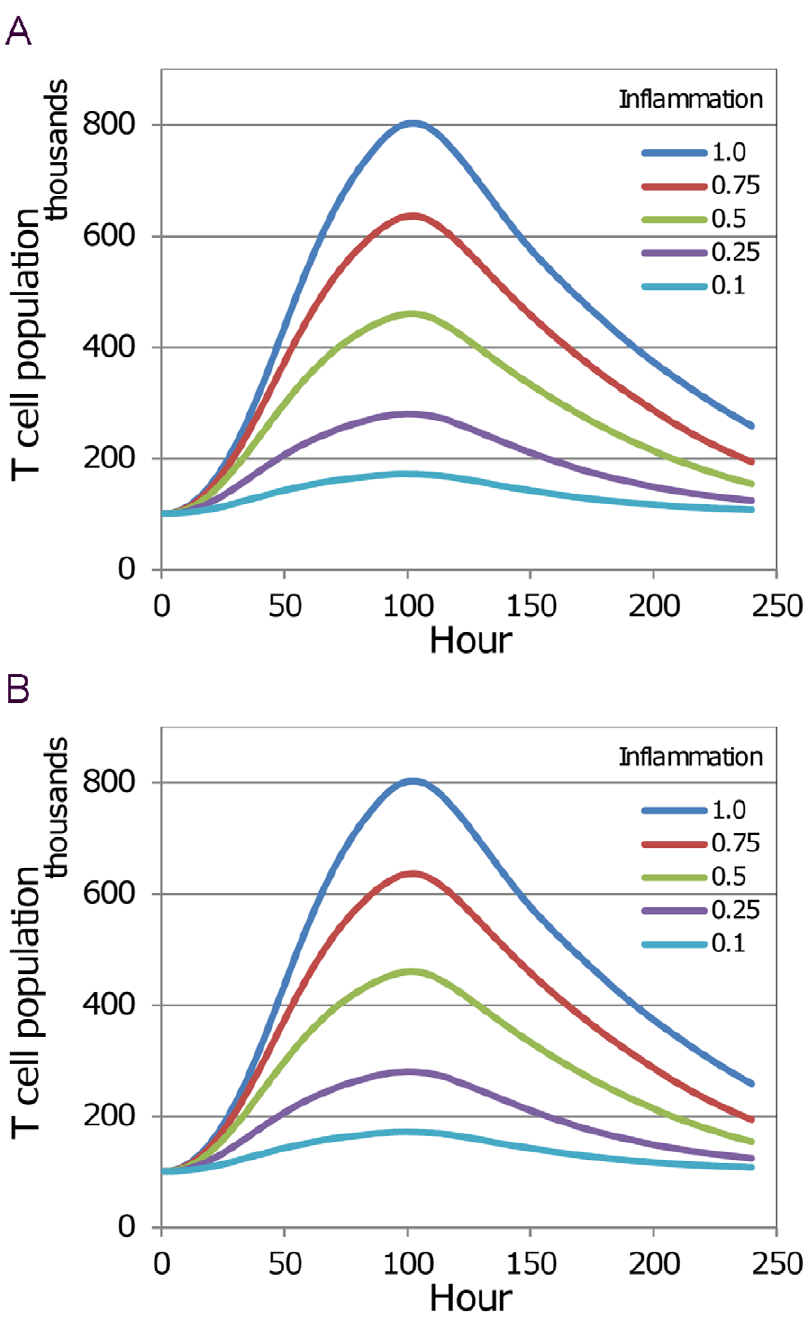
Figure 4. Time course of simulated T cell population for varying levels of inflammation signal. In each 10 day simulation run, with a starting population of 100 k T cells, the external inflammation signal was held at fixed level (0.1, 0.25, 0.5, 0.75, 1.0) for 3.5 days, then ramped to zero over 24 hours. The T cell population of the blob rises initially while inflammation-driven influx exceeds efflux, then falls back towards the initial level as steady-state balance of inflow and outflow is restored. (A) Simulations with T res =12 h. (B) Simulations with T res =24